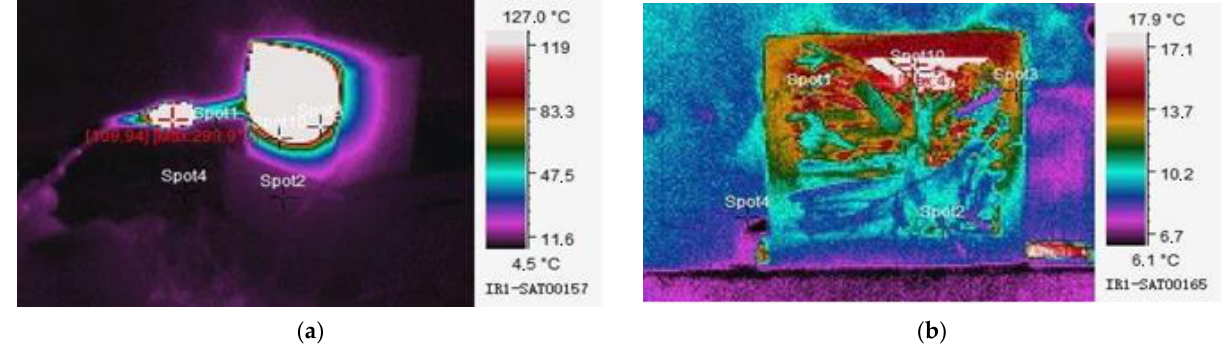
Figure 7. ( a ) Temperature distribution on the surface of a cube exposed to flame after t = 25 min (a maximum range of the thermal imaging camera was 300 °C); ( b ) Temperature distribution on the opposite side of the sample after t = 25 min.